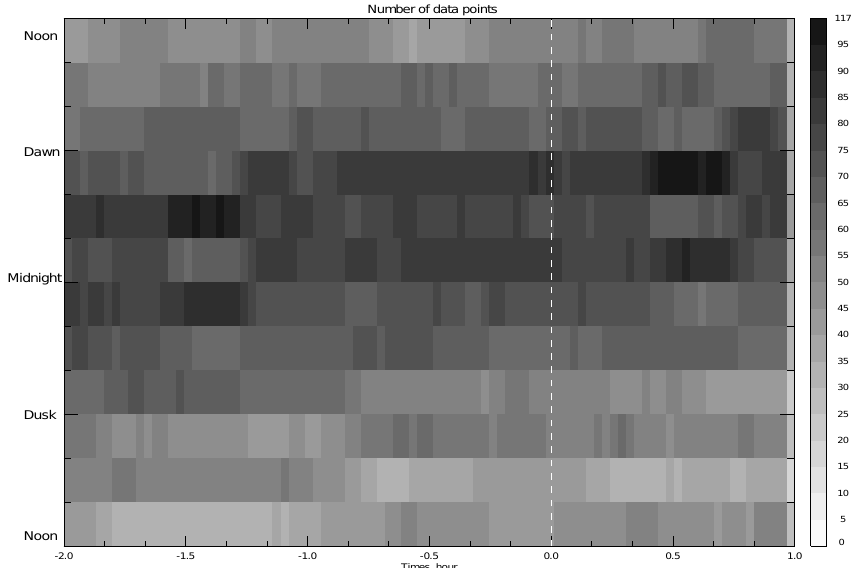
Fig. 6. Local time–universal time distribution of the number of GOES data points for the averaging process during individual teeth. See Fig. 5 caption. The dashed vertical line indicates the onset of a rapid proton flux increase of each tooth.